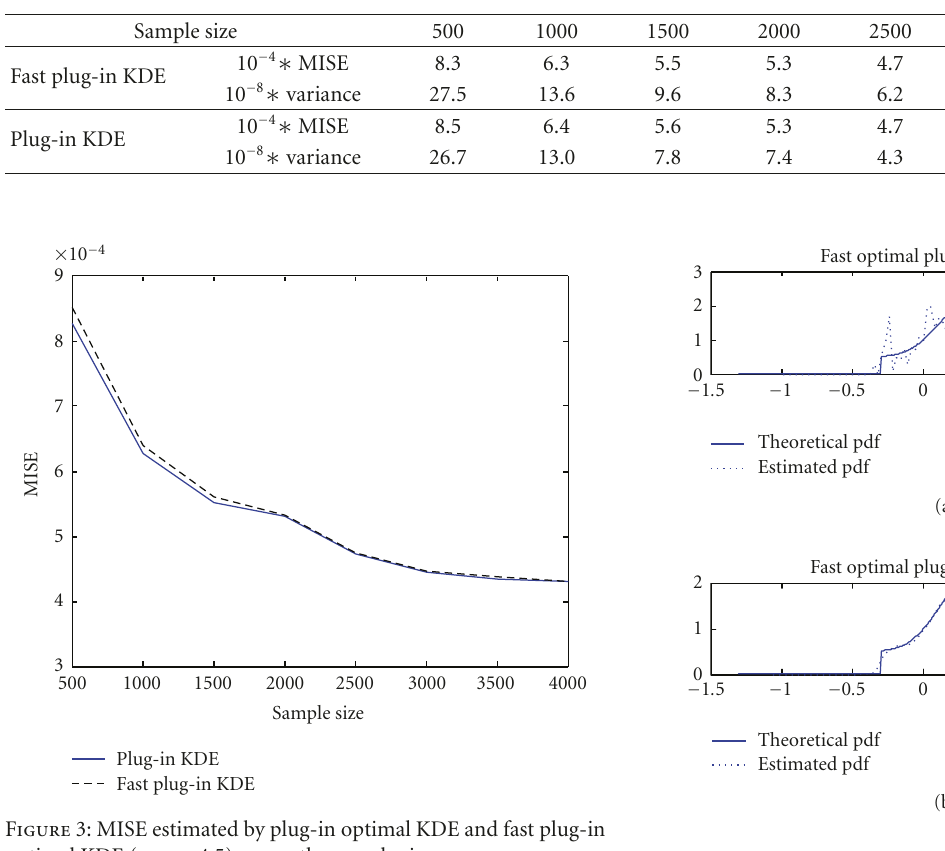
Table 3: Convergence of MISE and variance values versus sample size computed from 1000 simulations of the theoretical distribution using the two studied KDE.